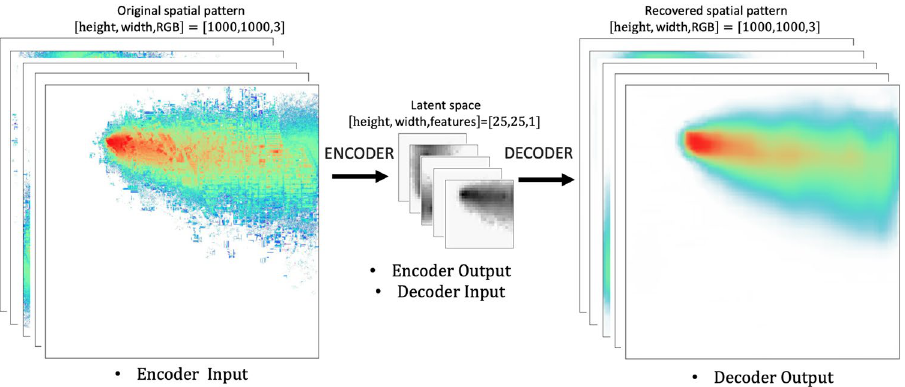
Figure 7. Schematic of the autoencoder architecture. The encoder receives the original image (shape [1000, 1000, 3]), and it reduces its size to 0.02% (shape [25, 25, 1]). The decoder can recover the original image from the reduced space quite